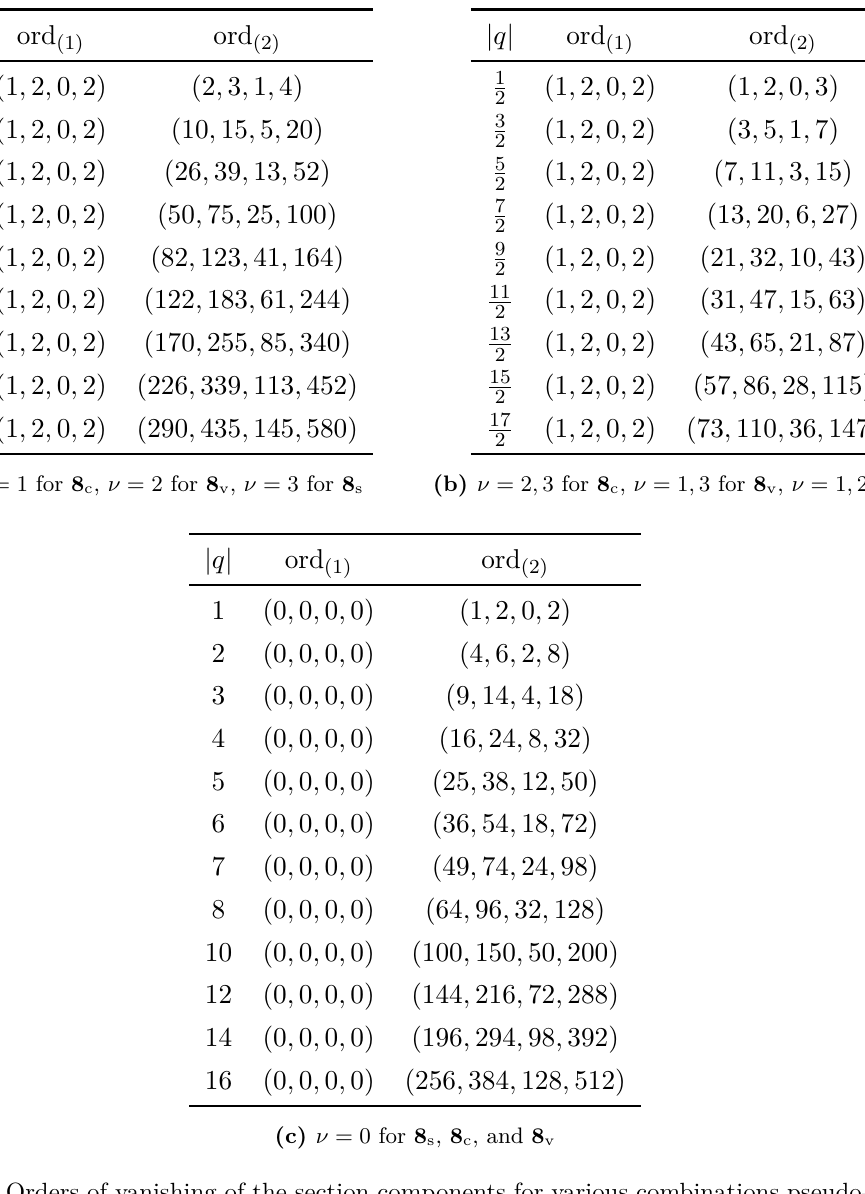
Table 16. Orders of vanishing of the section components for various combinations pseudo-charges q and ν for 8 s , 8 c , and 8 v matter in so (8) ⊕ u (1) models. The data are obtained using the so (8) ⊕ u (1) model in eq.